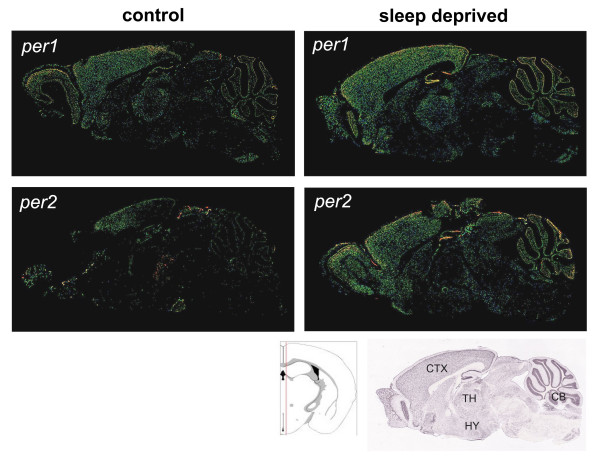
In situ hybridizations for per1 (upper) and per2 (middle panels) expression in four sagittal brain sections from sleep deprived (SD, right) and control (left panels) mice. All sections were taken close to mid-line (see lower panel; red vertical line in coronal section indicates the plane of the sagittal sections). per was expressed mostly in cortex and cerebellum and SD induced an increase in both these areas, confirming our own per1 expression data (Fig. 4). These data were taken, with permission, from the publicly available in situ studies of the Allen Institute for Brain Science [60], done in collaboration with Drs. T.S. Kilduff and J.P. Wisor of SRI International. The experimental protocol was identical to that of the 6 h SD in the present study; both SD and control animals were sacrificed at ZT6. ID numbers of sections: per1 control: 145-0202054795 at 3625; SD: 153-0202055093 at 3825; per2 control: 140-0205056163 at 3500; SD: 132-0205058042 at 3300. Lower right panel is the histological view (Nissl stain) of the upper right panel (per1-SD) with cerebral cortex (CTX), thalamus (TH), hypothalamus (HY), and cerebellum (CB). The presence of EEG electrodes in some mice caused cortical damage during brain removal.